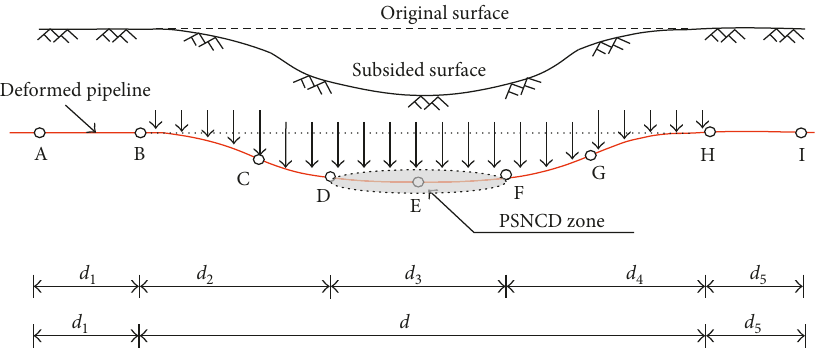
Figure 4: Buried pipeline in the PSNCD stage.